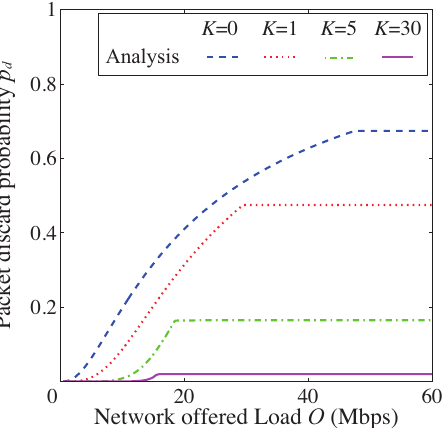
Figure 12. Packet discard probability as a function of offered load for N = 5 and K = 0,1,5, and 30.